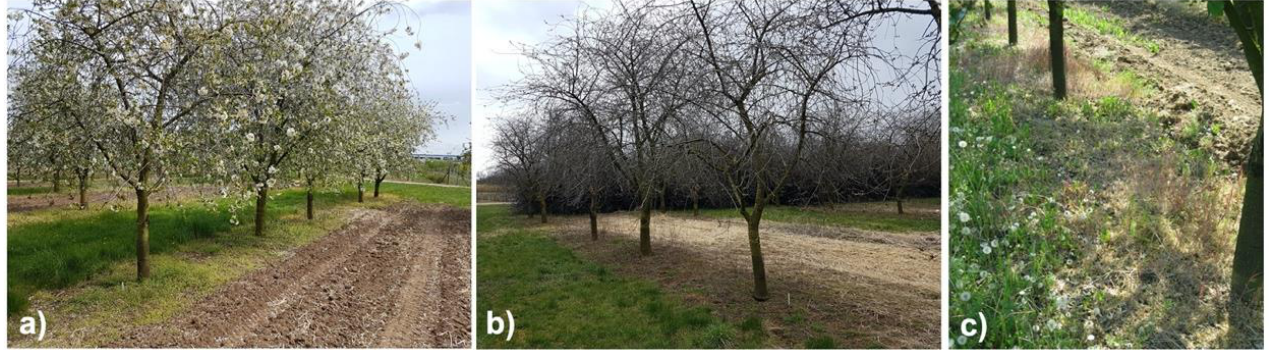
Figure 2. Orchard and three methods of vegetation management: ( a ) bare soil; ( b ) greening; ( c ) under trees.